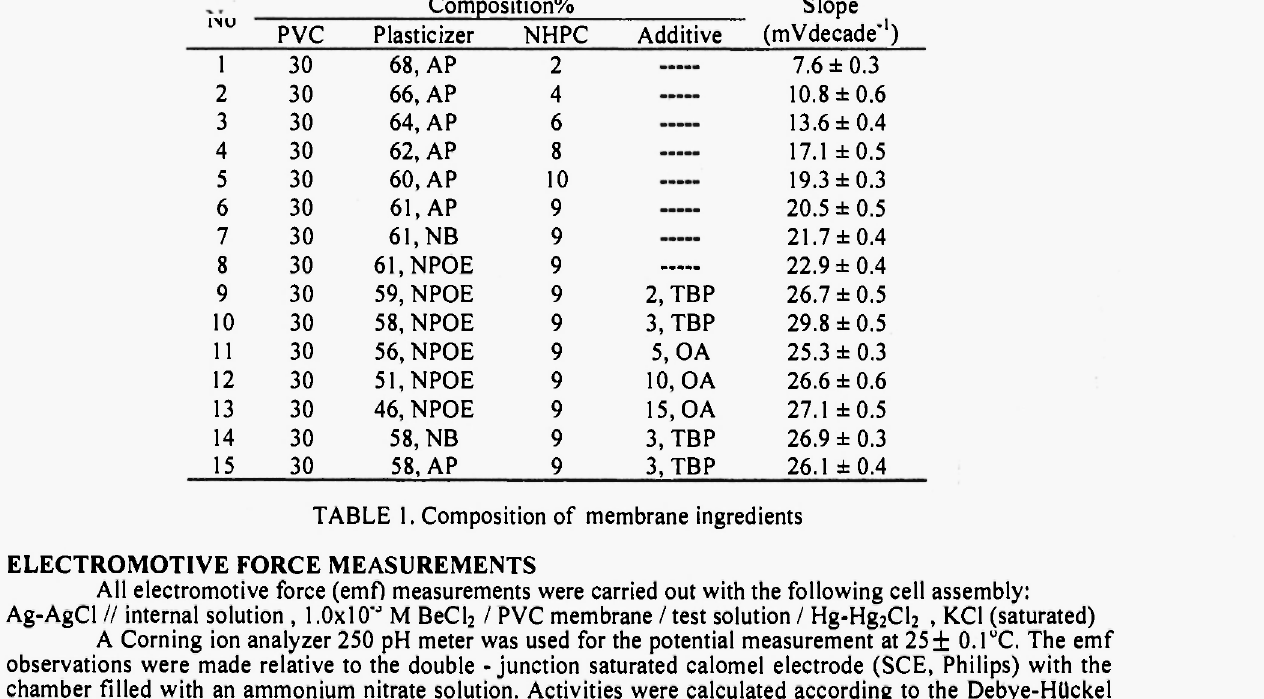
TABLE 1. Composition of membrane ingredients